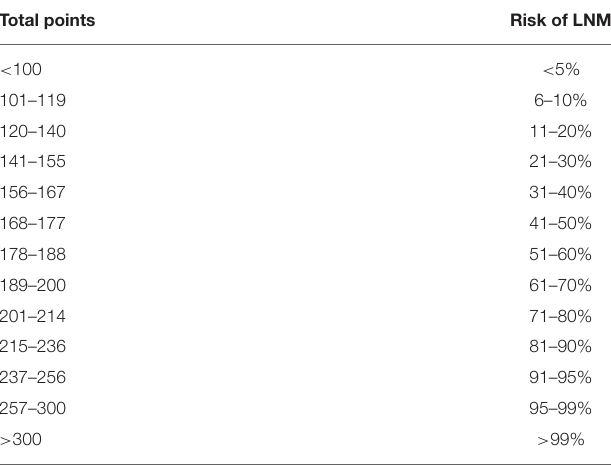
TABLE 4 | The relationship between total points and risk of LNM in T1 colorectal cancer. Total